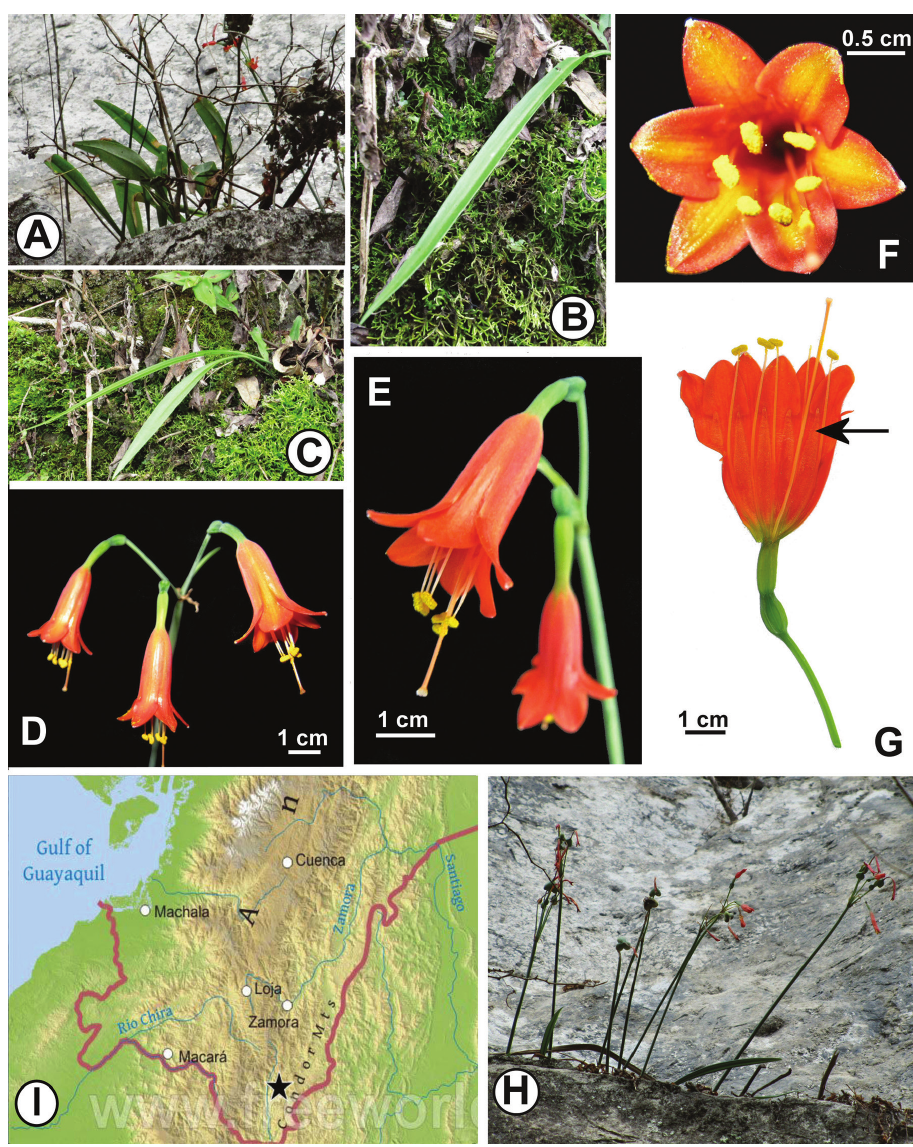
Figure 1. Stenomesson ecuadorense . A–C Plants in habit on limestone cliff D–G Inflorescence and flow- ers. Arrow in G denotes androecial teeth interposed between the free filaments H Plants in fruit in habitat I Distribution in Ecuador (black star). Map courtesy of www.freeworldmaps.net. The apparent yellowish stripes in Fig. 1F are artifacts of camera flash reflectance and are not visible by